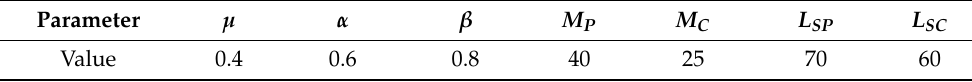
Table 5. Related Parameters of the System and the